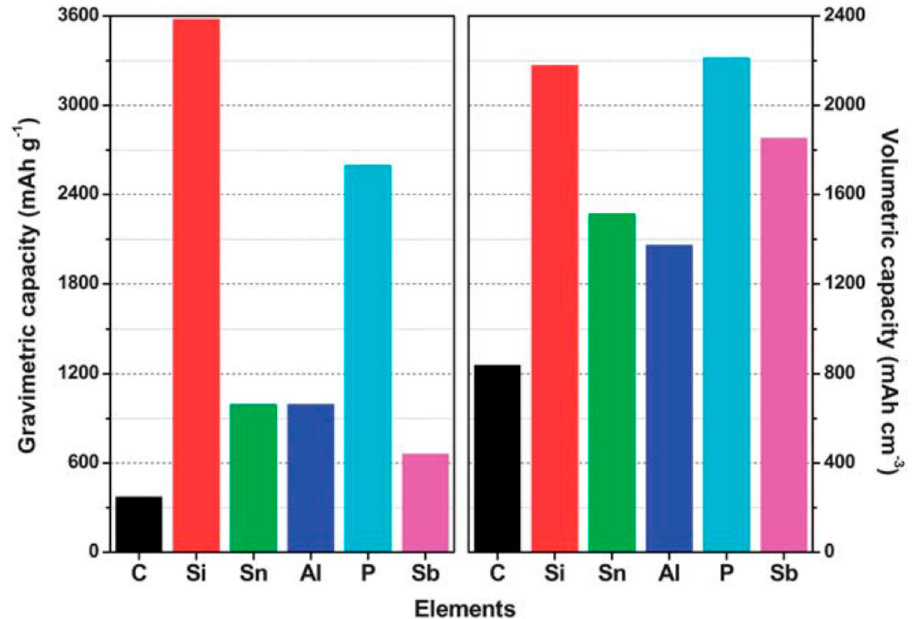
Figure 13. Theoretical gravimetric and volumetric capacities of C (LiC 6 ), Si (Li 3.75 Si), Sn (Li 4.4 Sn), Al (LiAl), P (Li 3 P) and Sb (Li 3 Sb). Adapted with permission from [141], © Royal Society of Chemistry, 2011.